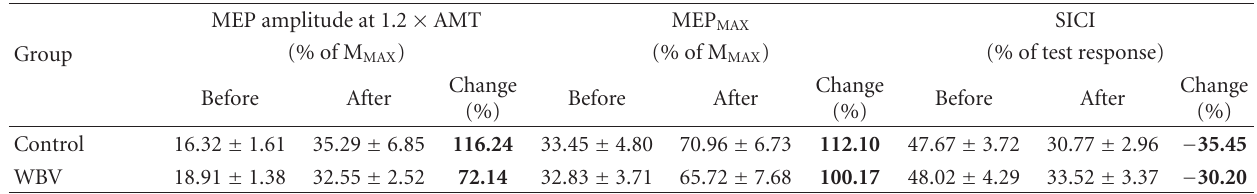
Table 2: Mean ± SE values and percentage change for corticospinal responses: MEP amplitude at 1.2 × AMT (% of M MAX ), MEP MAX (% of M MAX ), and conditioned MEP amplitude as a percentage of the test response (short-latency intracortical inhibition (SICI)).